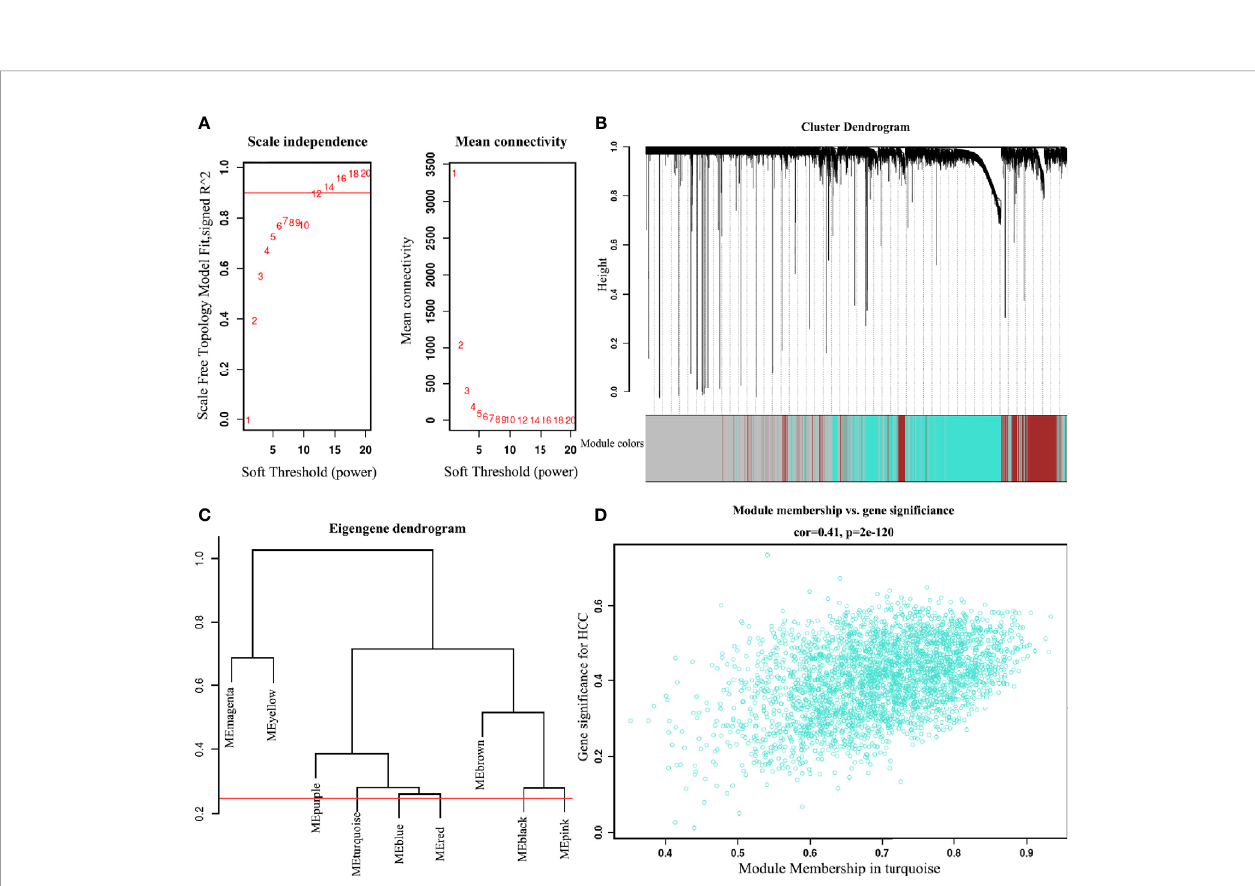
FIGURE 4 | Identify the key module of the LIHC dataset by WGCNA (A) Analysis of soft-threshold powers with the scale-free index and the mean connectivity. (B) Dendrogram of all fi ltered genes enrich according to a dissimilarity measure and the cluster module colors in the mRNA expression (minimum number of genes in the module is 30). (C) Adjust cut-height as 0.25 (the red line) to cluster the module eigengene. (D) Correlation of the co-expressed genes in the turquoise model. Each dot is one gene of the